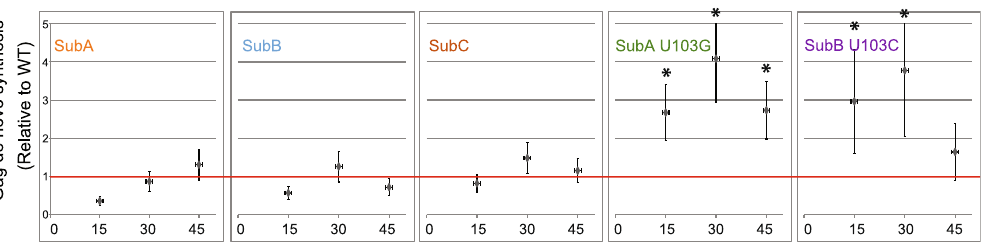
Figure 3. Addition of U103 substitution to monomer 5 ′ UTRs significantly increased translation rate. Statistical analysis of results of five independent translation rate experiments (representative in Fig. 2) with each molecular clone by a linear mixed model. Statistically significant differences relative to WT (p < 0.05) (astericks) were validated in the rate of polypeptide synthesis between WT, SubA U103G and SubB U103C, but not SubA, SubB, SubC. ( a ) Average ratio ( ± standard error) of de novo Gag synthesis at each time relative to WT at time 15. Separate plots present each molecular clone (black line) relative to same WT (grey line). ( b ) Average fold difference ( ± standard error) at each time interval in de novo Gag synthesis relative to WT. Red line, no difference from